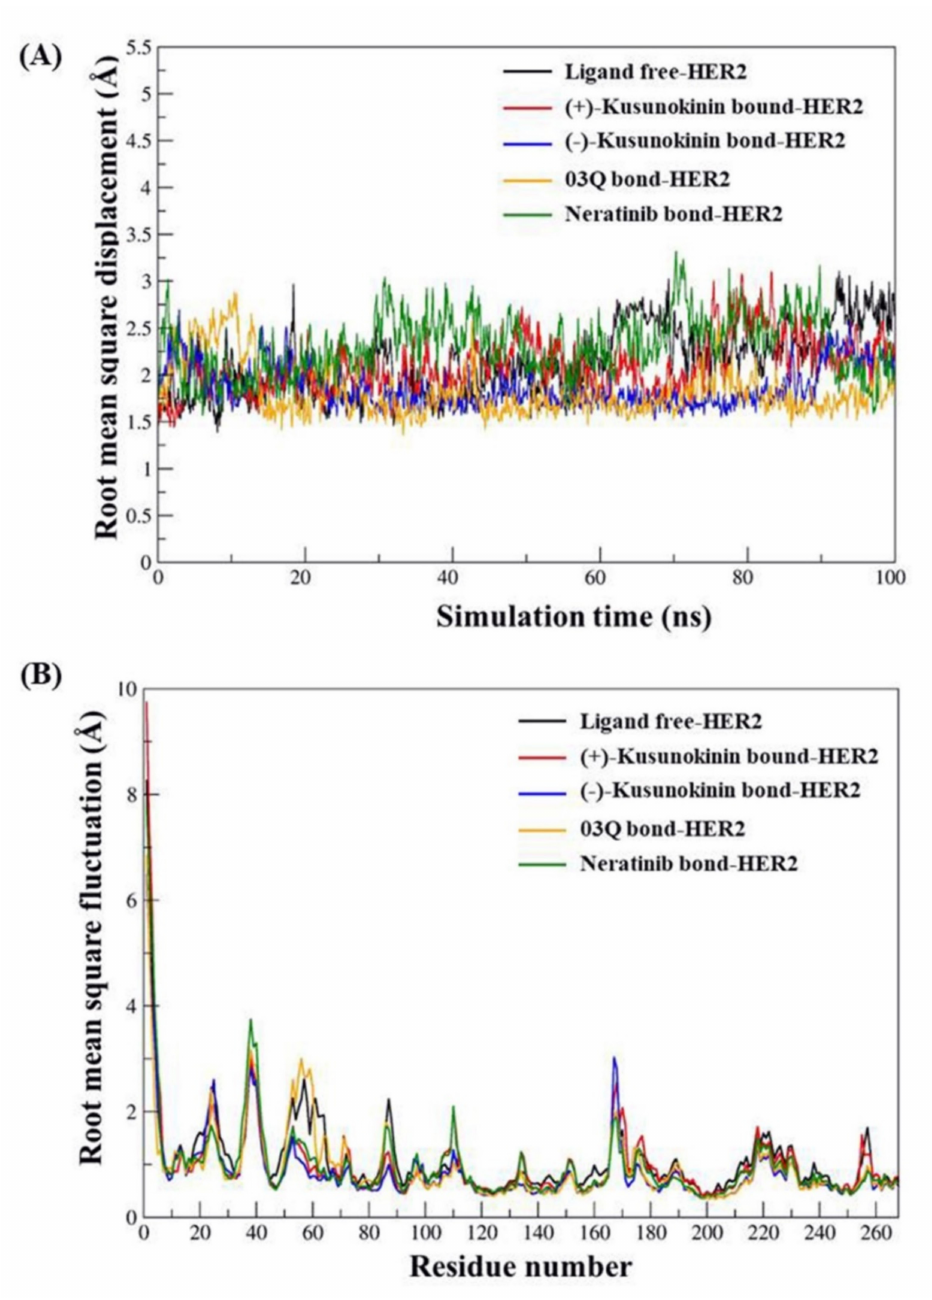
Figure 2. Root mean square displacement (RMSD) and root mean square fluctuation (RMSF) from lig- and bound HER2 simulations. ( A ) RMSD plot was computed from 100 ns MD trajectories. ( B ) RMSF plot was derived from an alpha carbon atom of each amino acid in the HER2 structure. Both RMSD and RMSF were reported in a units of angstrom